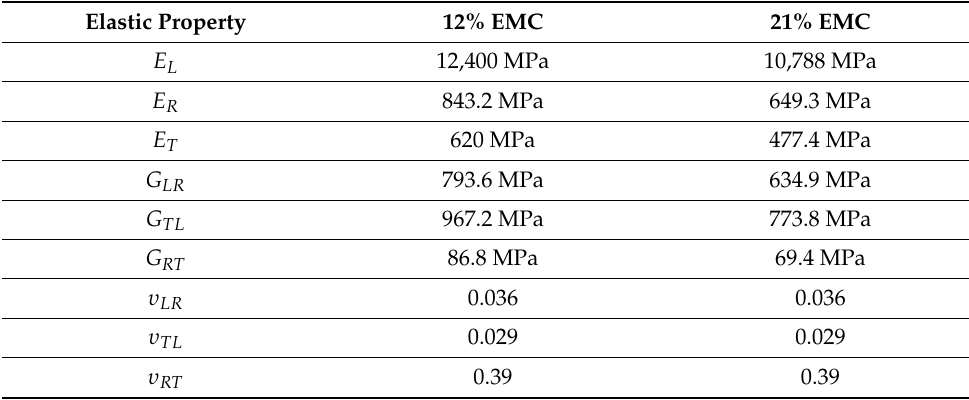
Table 10. 130 × 260 mm and 80 × 160 mm glulam material properties [18].